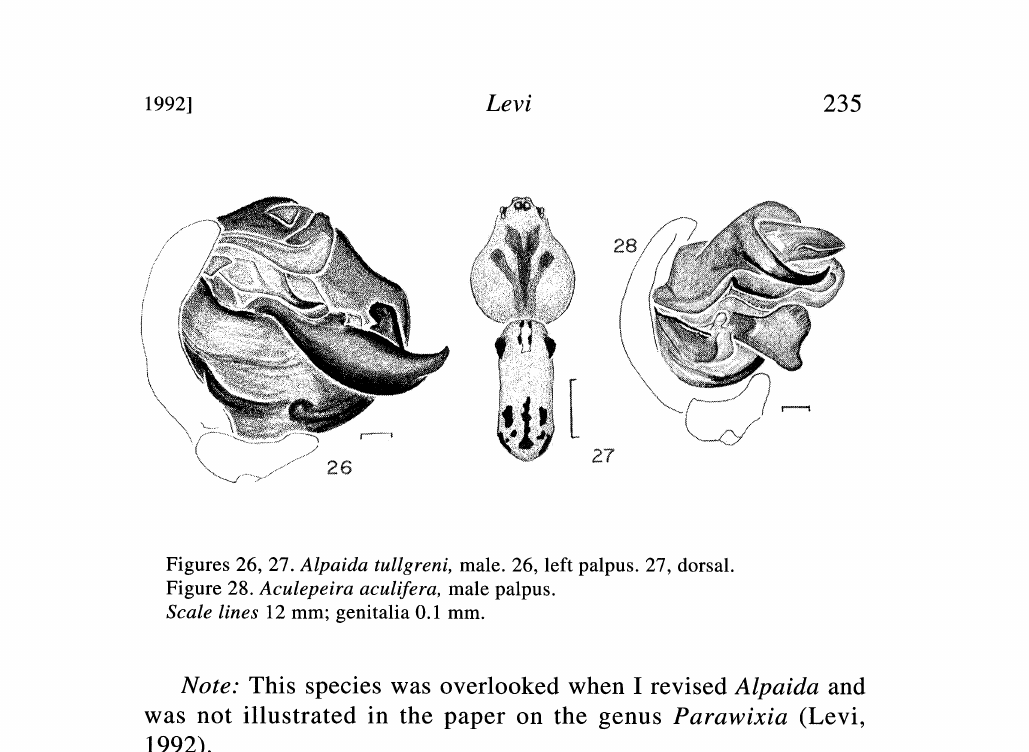
Figures 26, 27. Alpaida tullgreni, male. 26, left palpus. 27, dorsal. Figure 28. Aculepeira aculifera, male palpus. Scale lines 12 mm; genitalia 0.1